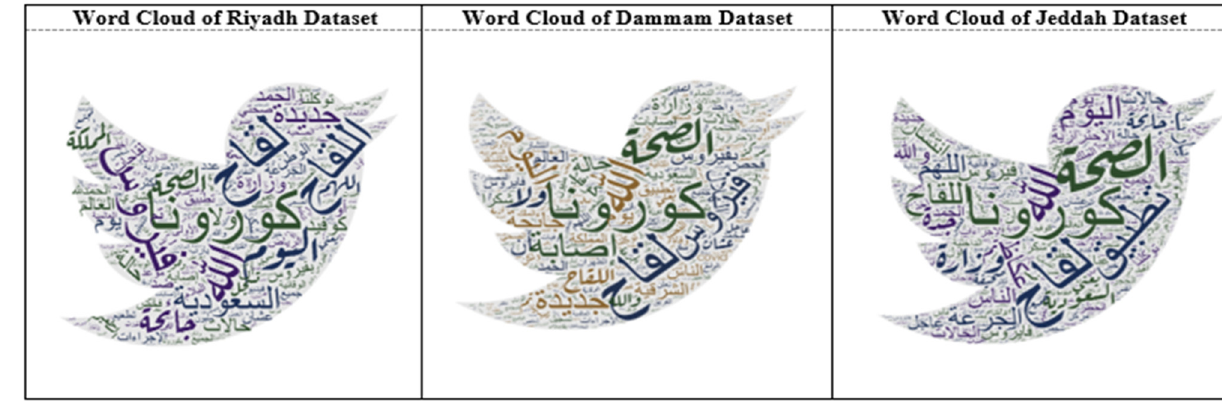
Figure 15. Word Clouds of datasets during COVID-19.